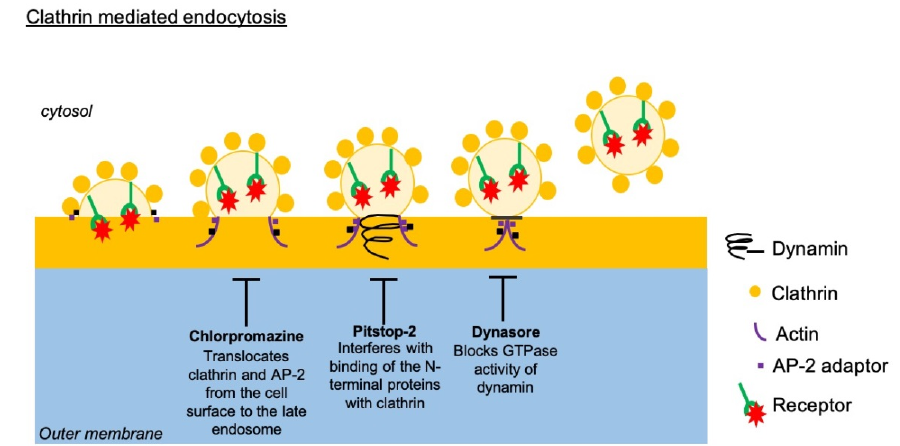
Figure 2. Blocking compounds affecting the clathrin-mediated endocytosis pathway. Schematic Figure2. Blockingcompoundsaffectingtheclathrin-mediatedendocytosispathway. Schematicrepresentation representation of clathrin-mediated endocytosis and the impact of blocking by chlorpromazine, ofclathrin-mediatedendocytosisandtheimpactofblockingbychlorpromazine, Pitstop-2, andDynasore. Vesicle formation is a ff ected by chlorpromazine, Pitstop-2, and Dynasore at di ff erent levels during the formation of the clathrin-coated